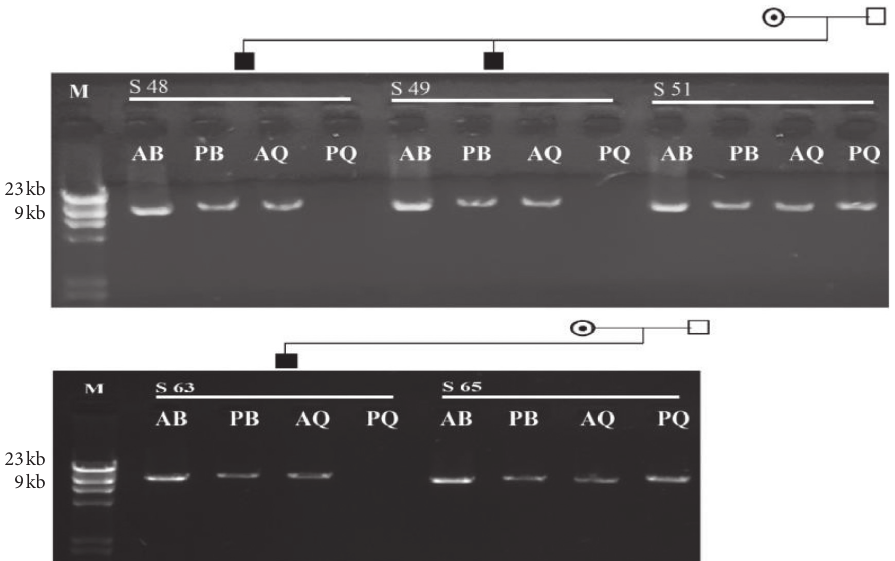
Figure 2: Family pedigree analysis of the carrier females included in the current study. AB, PB, AQ, and PQ are primers related bands. ʘ meanscarrier; ■ meansaffected male; □ meansunaffected male. M: λ DNA HindIII marker (0.1 kb–23kb); S: sample number.